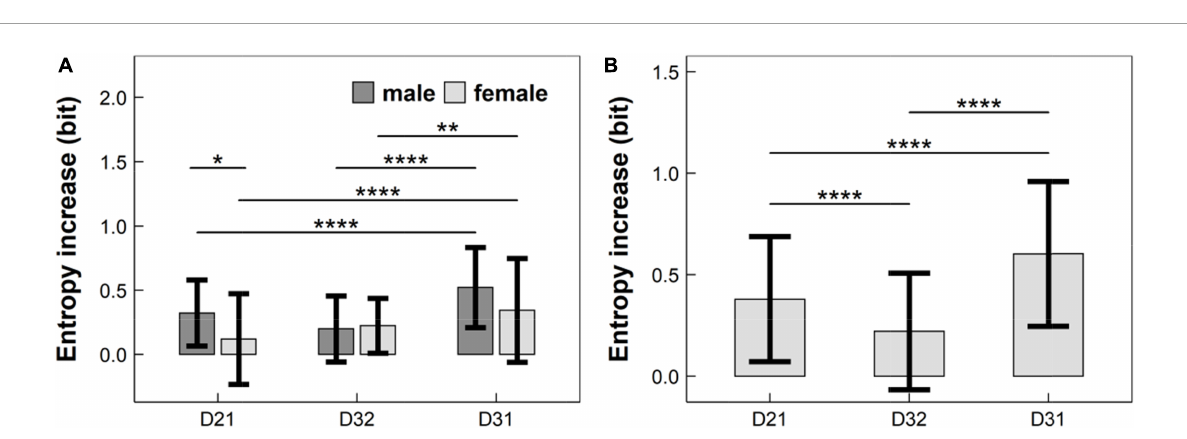
FIGURE4 Entropy increases caused by the change of experimental conditions in: (A) children aged 7 years; and (B) children aged 8–11 years, where entropy increases D 21 , D 32 , and D 31 , defined in Equation (6), were corresponding to the EME change from Condition C1 to C2, from Condition C2 to C3, and from Condition C1 to C3, respectively. EME: eye-movement entropy; *: p < 0.05; **: p < 0.01; ****: p < 1 × 10 − 4 .